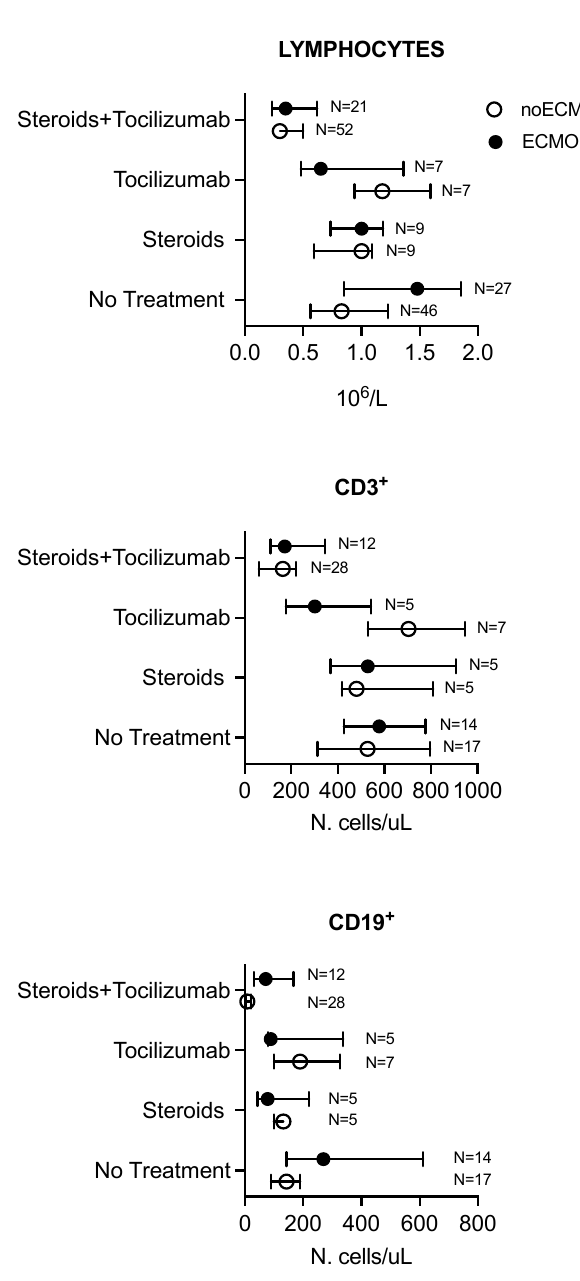
Figure 1. Total lymphocyte, CD3 + , and CD19 + subpopulation counts in the presence or not of steroids and Tocilizumab therapy in COVID-19 patients with ARDS who required or not ECMO support. On the contrary, in the no VV-ECMO group, administration of Tocilizumab was as- sociated with a 79% increase in total lymphocytes compared to no treatment (Table 2). In the no VV-ECMO group, both Tocilizumab and a combination of Steroids + Tocilizumab were significantly associated with a reduction in the inflammatory marker procalcitonin compared to no treatment (Supplementary Materials File Table S3). For the remaining outcomes evaluated, the results from the model without an effect modification by VV- ECMO are shown. The CD45 + , CD3 + CD4 + (Th cell), CD3 + CD8 + , CD4 + /CD8 + , NK cell subpopulation, neutrophils, monocytes, and basophils counts were significantly reduced by treatment with Steroids + Tocilizumab without any interaction with VV-ECMO